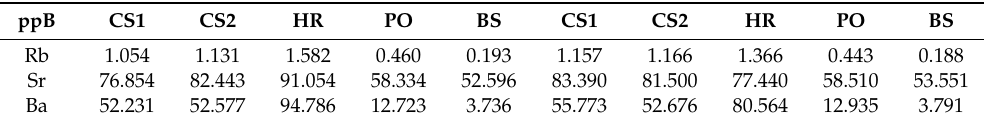
Table 3. CS1 and CS2: Hérault intrusions in CS, HR: Hérault, BS: Buèges, PO: Pump output.